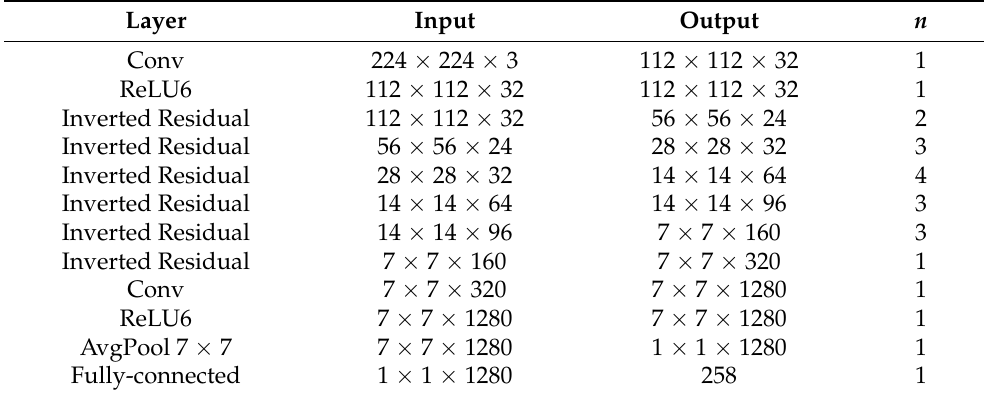
Figure 3. MobileNetV2’s architecture consists of a convolutional (conv) and Rectified Linear Unit (ReLU) layers, followed by 19 inverted residual (inv res) layers. The data is then passed through a dropout layer and an average pooling (avg pool) layer. Finally, a fully connected (fc) layer and a softmax layer are used to perform classification. The side branches are then introduced in the indicated positions. Table 1. MobileNetV2’s